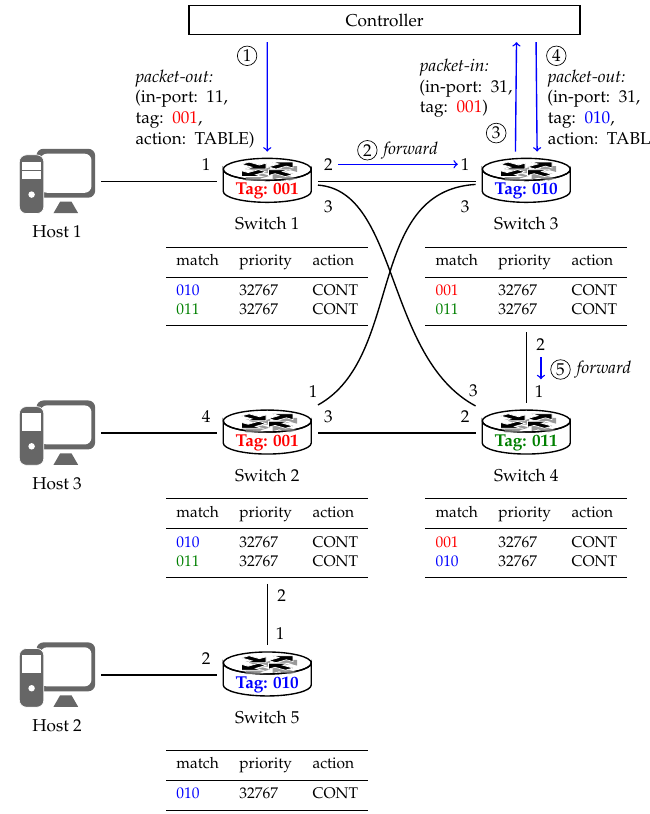
Figure 6. Example for tracing packet routes with software-defined networking (SDN)